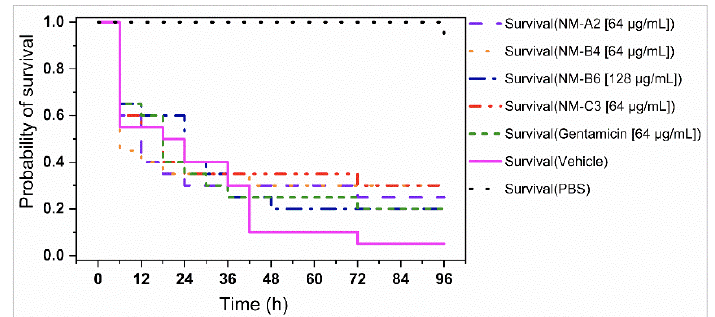
Figure 4. Kaplan–Meier survival plot showing the probability of survival of G. mellonella larvae in- fected with K. pneumoniae (ATCC 10031) and treated with the isolated compounds, as well as posi- tive and negative controls.